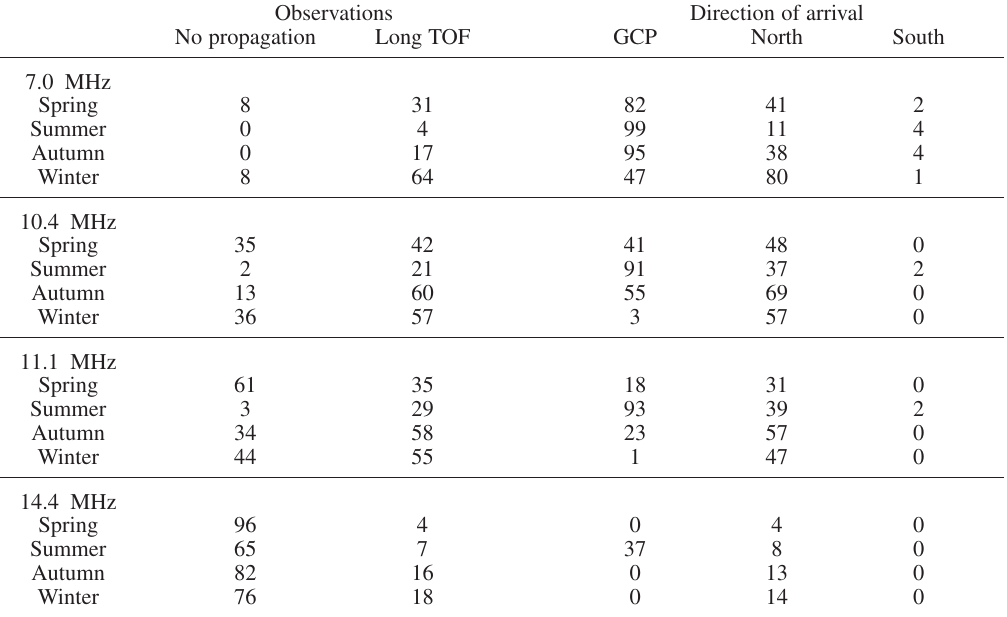
Table 14.I. Occurrence statistics by mode and bearing for 7.0, 10.4, 11.1 and 14.4 MHz signals during 2001 (all figures represent percentage of nights). Observations Direction of arrival No propagation Long TOF GCP North